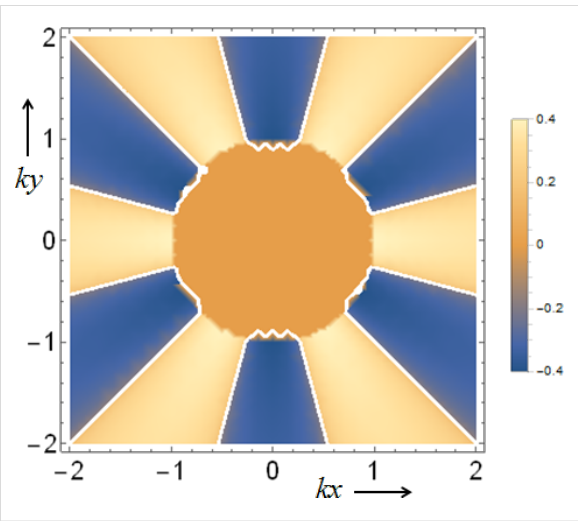
Figure 7: A density plot of the scaled spin in the radial direction sgn( S r )| S r | 1/5 in the ( kx , ky )-plane in the case of a counter-rotation. The data are R ρ ≡ kR = 1, m = 3, and q = i .